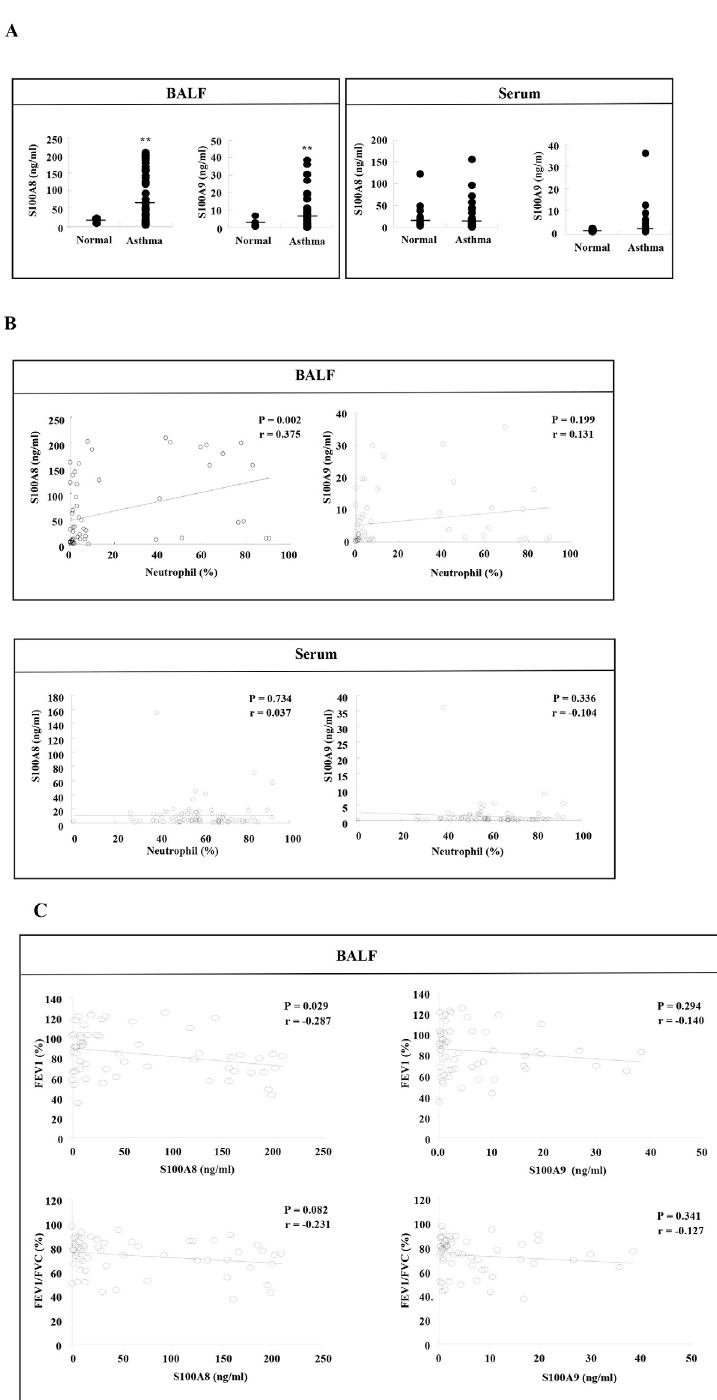
Fig 6. Elevated S100A8 level in BALF is associated with an increase of BALF neutrophils and a decrease of physiological function. (A) The concentration of S100A8 and S100A9 in BALF and serum of normal (6 < n < 26) and asthmatic subjects (61 < n < 94) was measured by ELISA as described in the Materials and Method section. ** p < 0.01 indicates a significant difference between the normal and asthmatic groups. (B) Linear regression represents the correlation between S100A8 or S100A9 and the number of neutrophils (%) in asthmatic subjects. (C) Linear regression represents the correlation between S100A8 or S100A9 in BALF and FEV1 (%) or FEV1/FVC